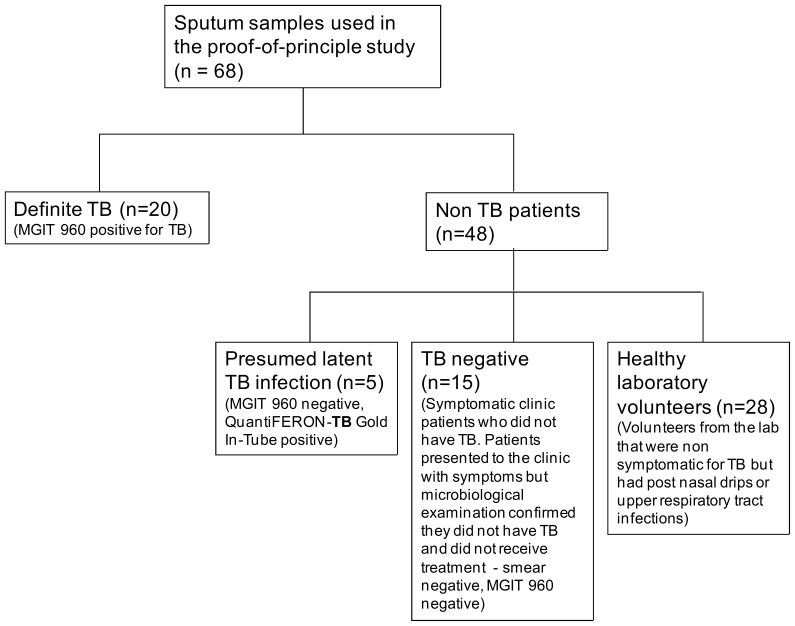
Study flow diagram.Study plan and patient categorisation of the 68 participants in active (definite) TB, latent TB, TB negative and healthy donors that were evaluated in the proof-of-principle study.